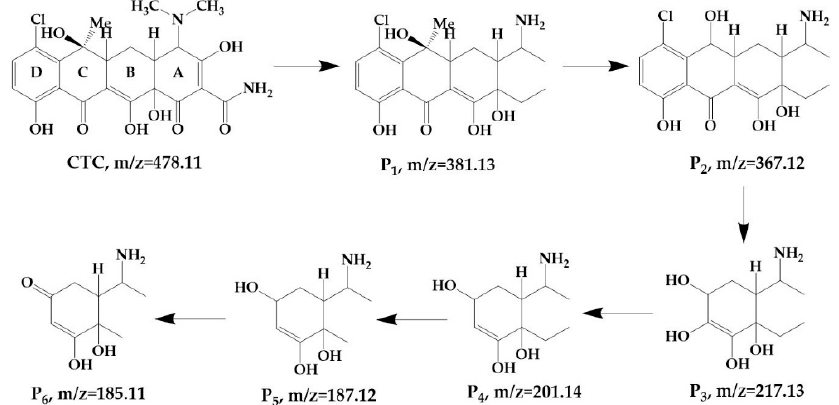
Figure 5. Possible pathways and degradation products of CTC by using HC.